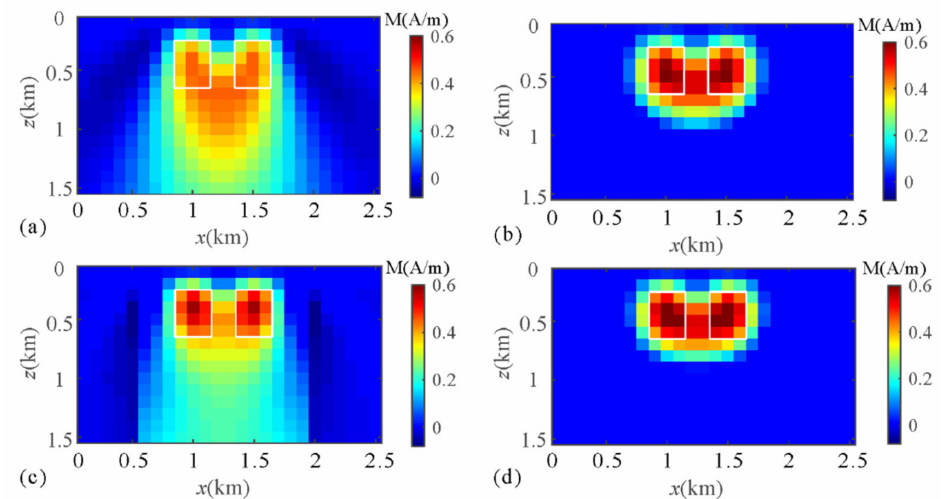
Figure 3. Vertical slices of the inversion results obtained by applying different constraints: ( a ) without constraints; ( b ) with constraints on the upper and lower bounds; ( c ) with constraints on the attribute of positive or negative; ( d ) with constraints on both upper and lower bounds and the attribute of positive or negative (The white rectangles represent the actual positions of the synthetic models and the magnetization of the two prisms is 1